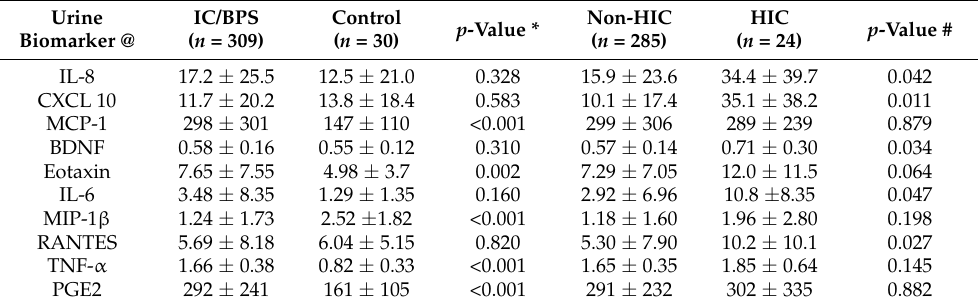
Table 1. The urine biomarkers between IC/BPS subgroup patients and controls.